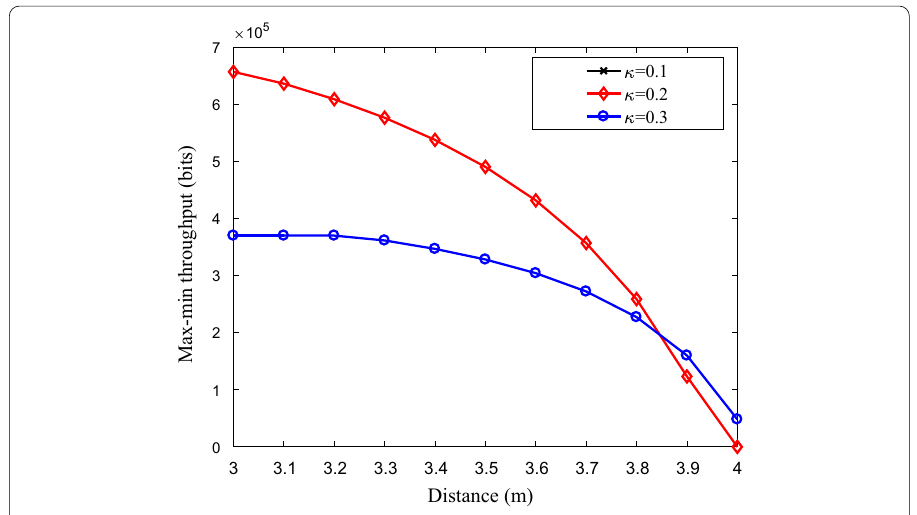
Fig. 6 Max–min throughput (bits) versus the distance of PT-BD with different level of HIs for P max = 5 dBm